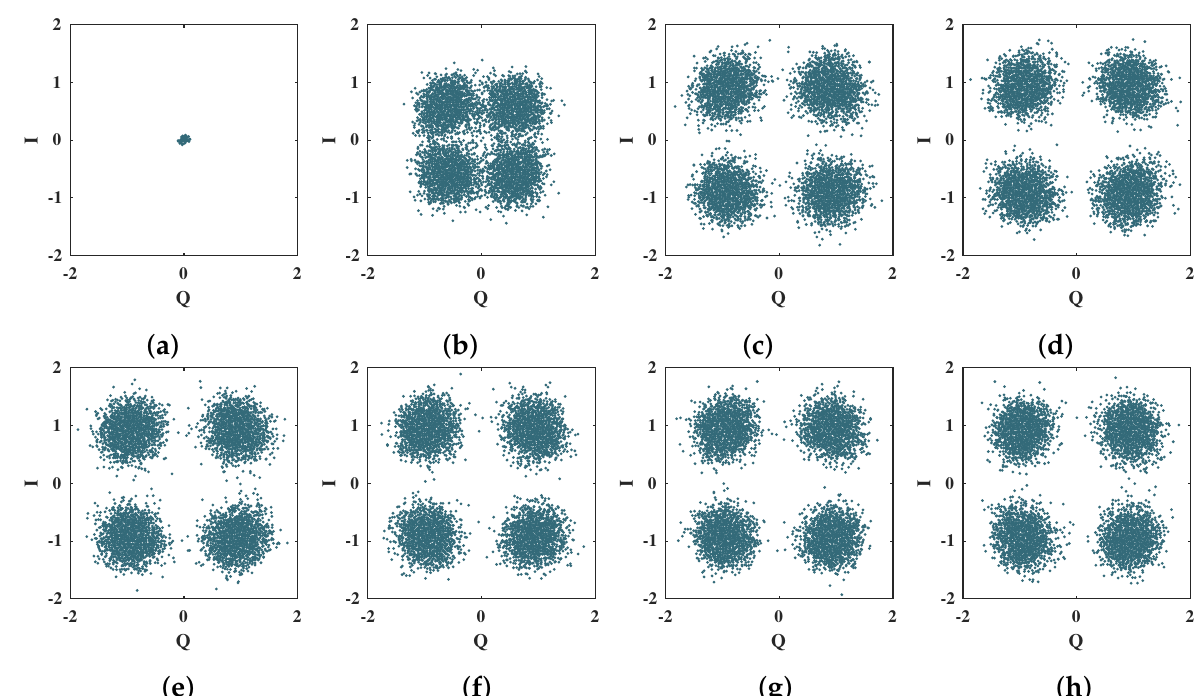
Figure 12. Scatter plots for the 4-QAM symbols at the output of the MMPTRBF during the training period, for M T = M R = 4